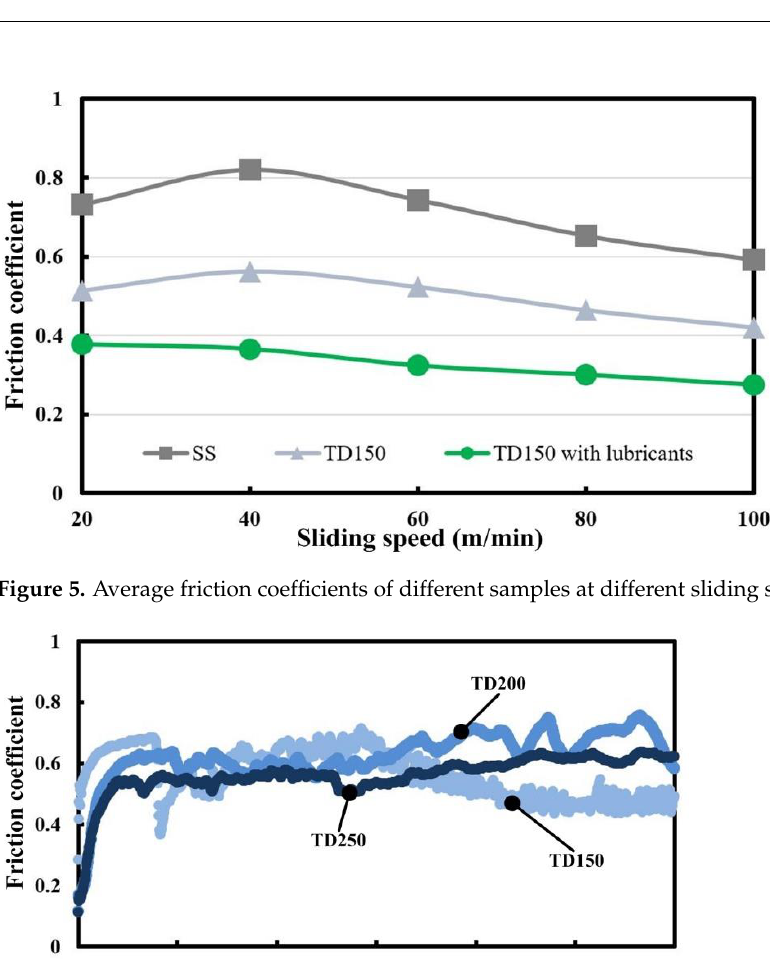
Figure 6. Variations of friction coefficient of different textured dimple samples at sliding speed of 40 m/min.